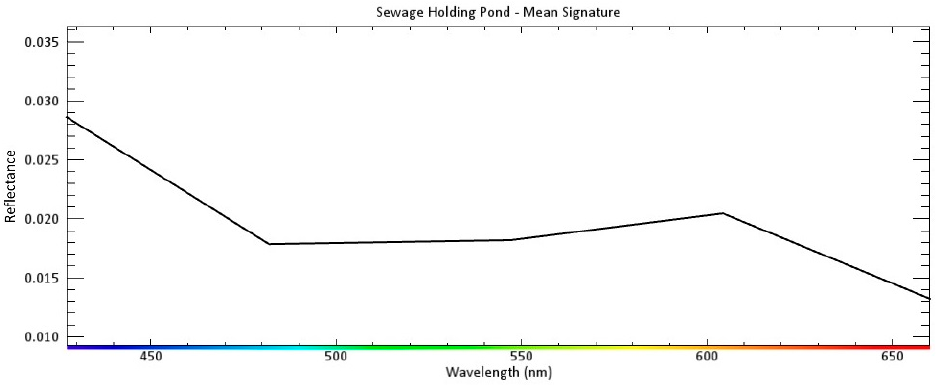
Figure 10. Mean spectral signature of a dark holding pond from the visible wavelength bands showing low reflectance values and higher blue wavelength